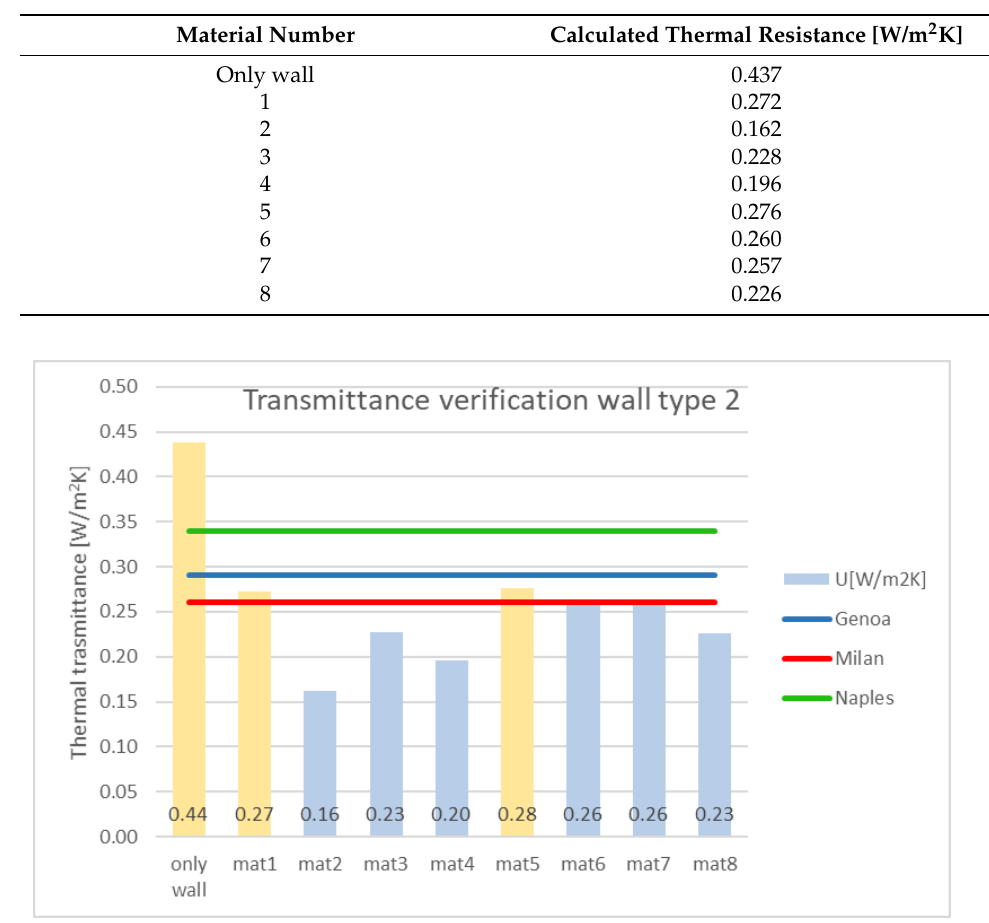
Figure A4. Wall type 2: transmittance check for the three main Italian climatic zones. In blue are the heat-reflective materials which respect all the limits.